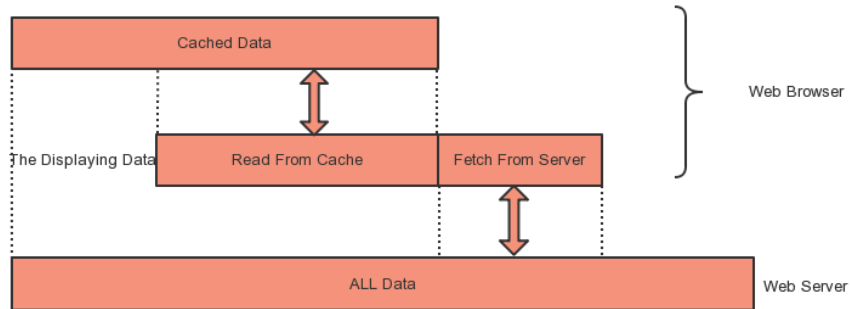
Figure 7. The plant electrical signals data transfer process.